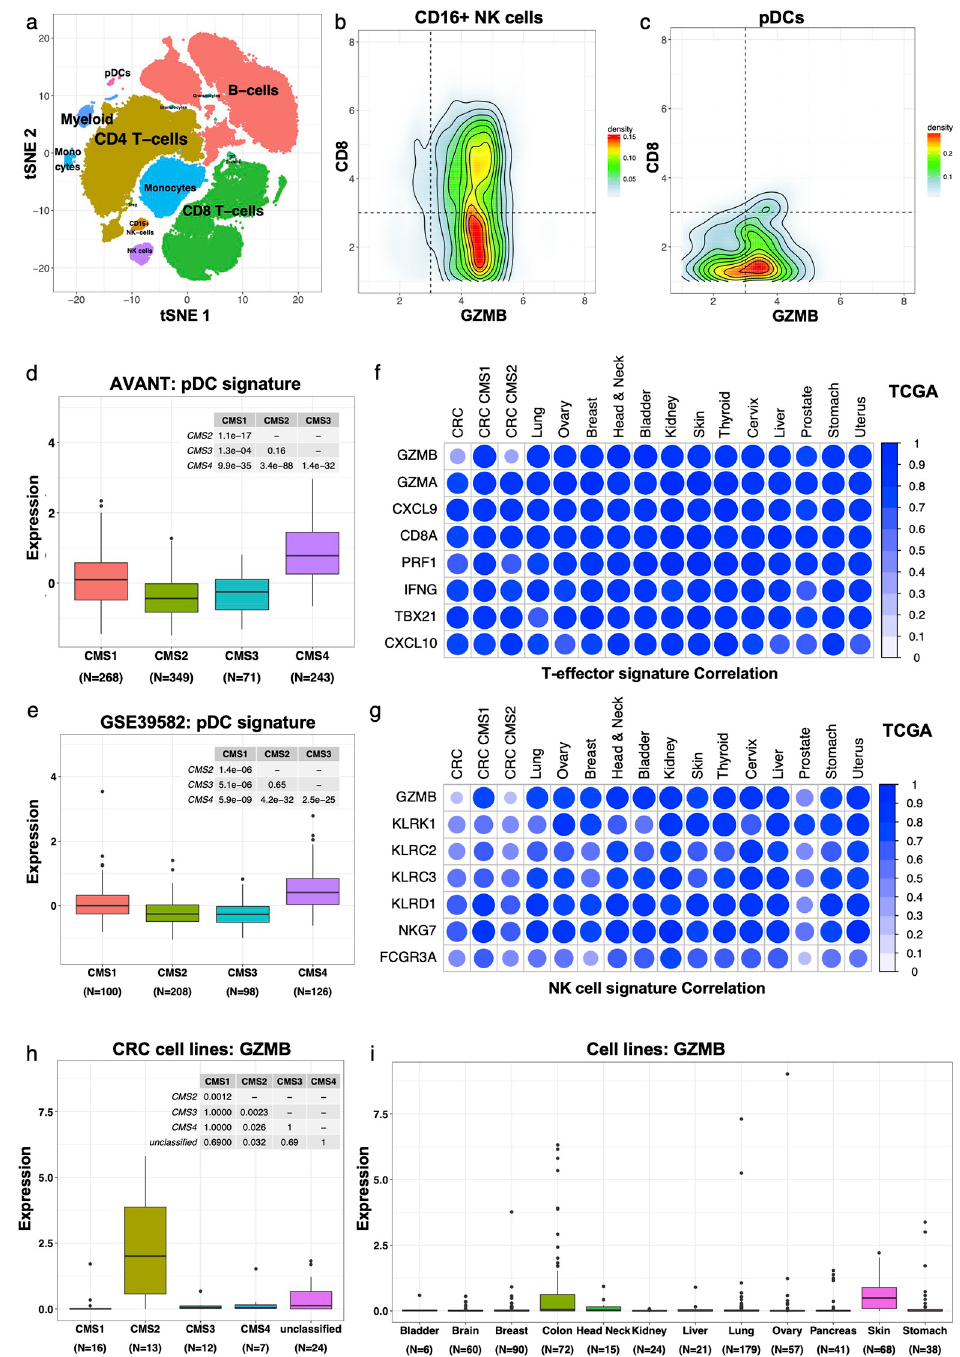
Fig 4. CMS2 CRC expresses endogenous GZMB. (a) tSNE map of the CD45+ immune cell populations in 12 procured CRC samples. Clusters representing different cell types are denoted by distinct colors, based on marker expression (see Materials and methods and S14a Fig). Outliers detected by density-based clustering were excluded. (b- c) CD8 versus GZMB expression in (b) CD16+ NK cells and (c) pDCs. (d-e) Expression of the pDC signature by CMS subtype in the (d) AVANT and (e) GSE39582 dataset. (f) Pearson correlation between expression of single genes from the T-effector signature and the average expression of the other T-effector genes without the gene in question, by cancer type and, for colon, by CMS subtype, in TCGA data. (g) Pearson correlation between expression of single genes from the NK signature and the average expression of the other NK genes without the gene in question, by cancer type and, for colon, by CMS subtype, in TCGA data. (h) GZMB expression (log2 nRPKM+1) by CMS subtype in CRC cell lines. (i) GZMB expression (log2 nRPKM+1) by cancer type in a cohort of 671 cell lines covering 12 cancer types.